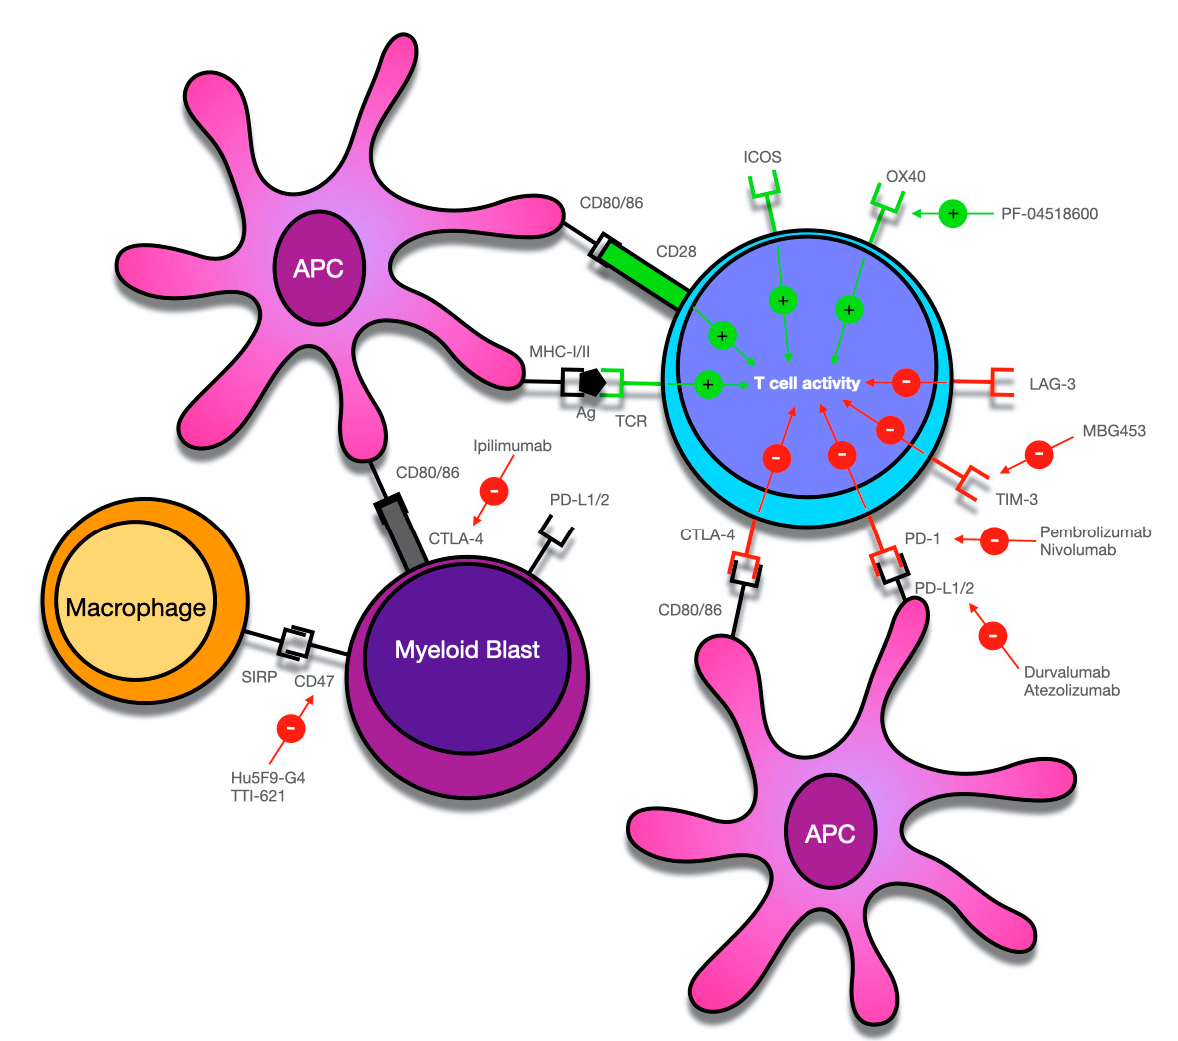
Figure 1. Overview of potential targets for immune checkpoint-mediated therapy in myeloid malignancies. Antigens (Ag), including tumor antigens, are bound to major histocompatibility complex (MHC)-I/II molecules by antigen-presenting cells (APC) and activate T-cells by binding to the T-cell receptor (TCR). Co-stimulatory signals such as activation of CD28 on T-cells by CD80 or CD86 is required for T-cell activation. The activity of T-cells is further regulated by various co-inhibitory (PD-1, CTLA-4, TIM-3, LAG-3) and co-stimulatory receptors (ICOS, OX-40), which can serve as potential targets for monoclonal antibodies that mainly block the activity of co-inhibitory receptors. However, as in the case of PF-04518600, activating co-stimulatory receptors can also be employed to increase the anti-tumor immune response. Myeloid blasts can also express various receptors on their surfaces, which create an immunosuppressive microenvironment and can contribute to immune system evasion. While thus far, T-cells have been the main focus of immune checkpoint-mediated therapy, current research has also identified the interaction of CD47 on APCs and myeloid blasts and SIRP α on macrophages as a potentially targetable mechanism of checkpoint therapy.